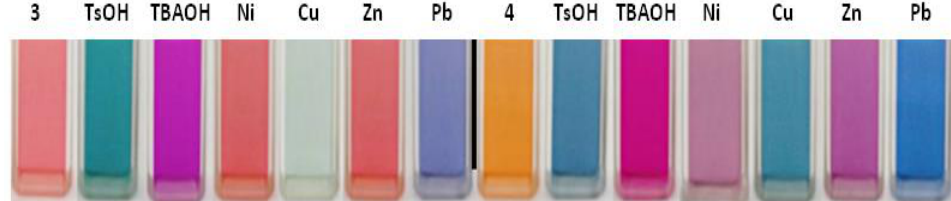
Figure 3. Qualitative probes showing color change of crowns 3 (2.01 × 10 − 5 M) and 4 (3.75 × 10 − 5 M) solutions (acetonitrile) in the presence of excess (added as solid substances, saturated solution) of p -toluenesulfonic acid (TsOH), tetra-n-butylammonium hydroxide (TBAOH) and nickel(II), copper(II), zinc(II) and lead(II) perchlorates in acetonitrile (photo was taken just after addition of the excess of acid, base and perchlorates).